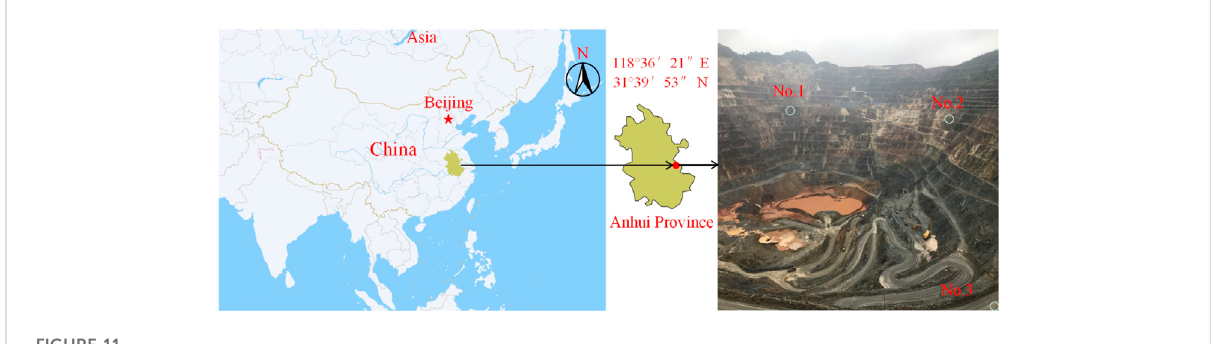
FIGURE 11 Layout of on-site measurement points.